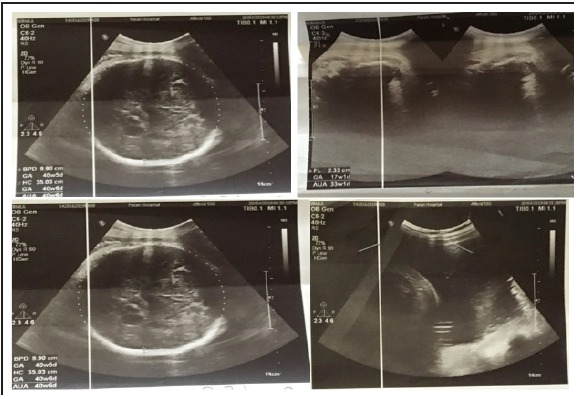
Figure 1. USG showing features suggestive of TSD. The emergency lower segment cesarean